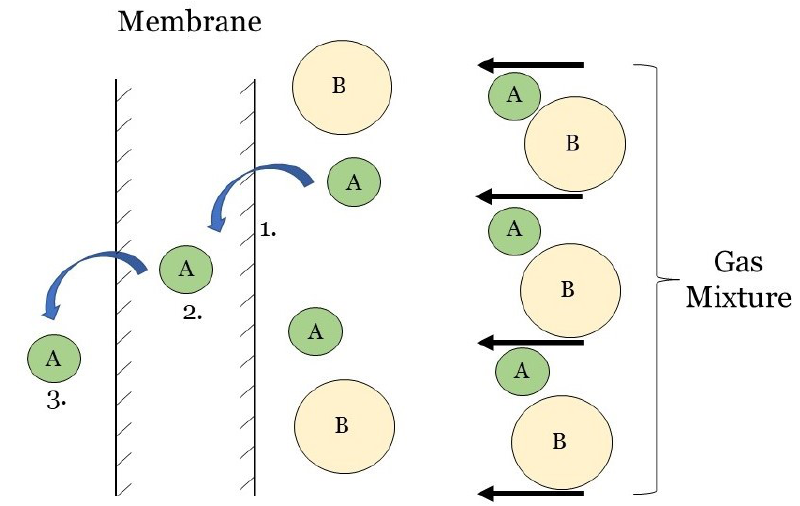
Figure 5. Graphical depiction of the solution-diffusion three-step process in a carbon capture HFMC for gas mixture of molecule A and B: 1. Molecule A sorption at the gas-membrane interface, 2. Molecule A diffusion through the membrane, and 3. Molecule A desorption at the solvent-membrane interface. The permeants are separated because of the differences in the solubilities and the variations in the diffusive rates of the different flue gas species in the membrane